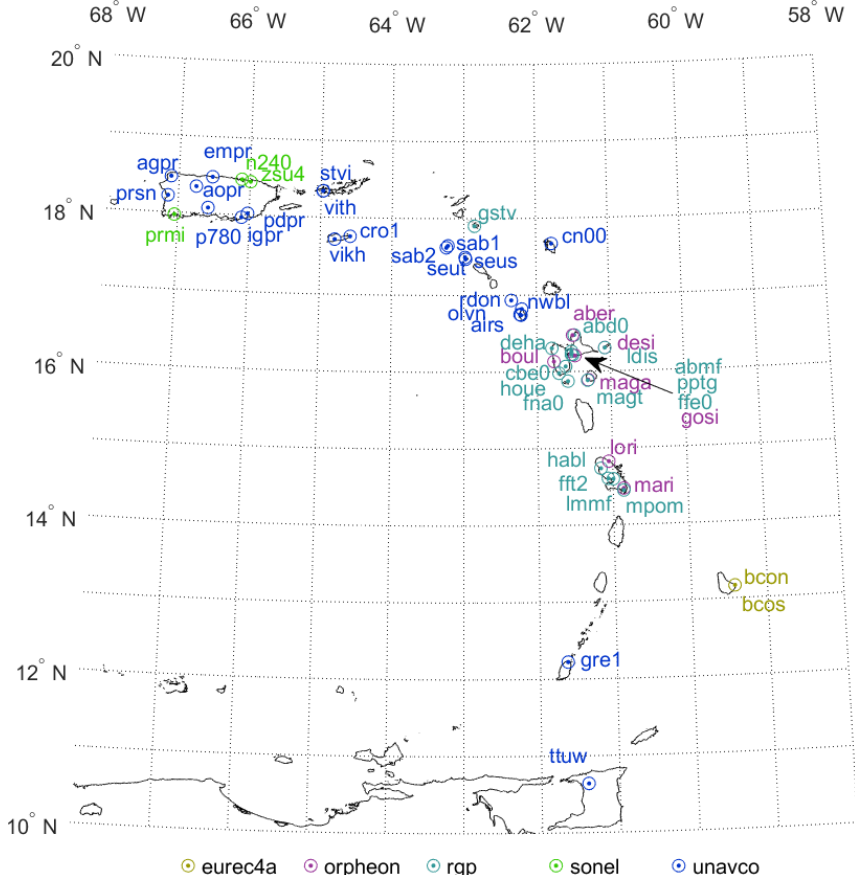
Figure 1. Map of GNSS stations for which the measurements were reprocessed from 1 January to 29 February 2020. The data sources are indicated below the